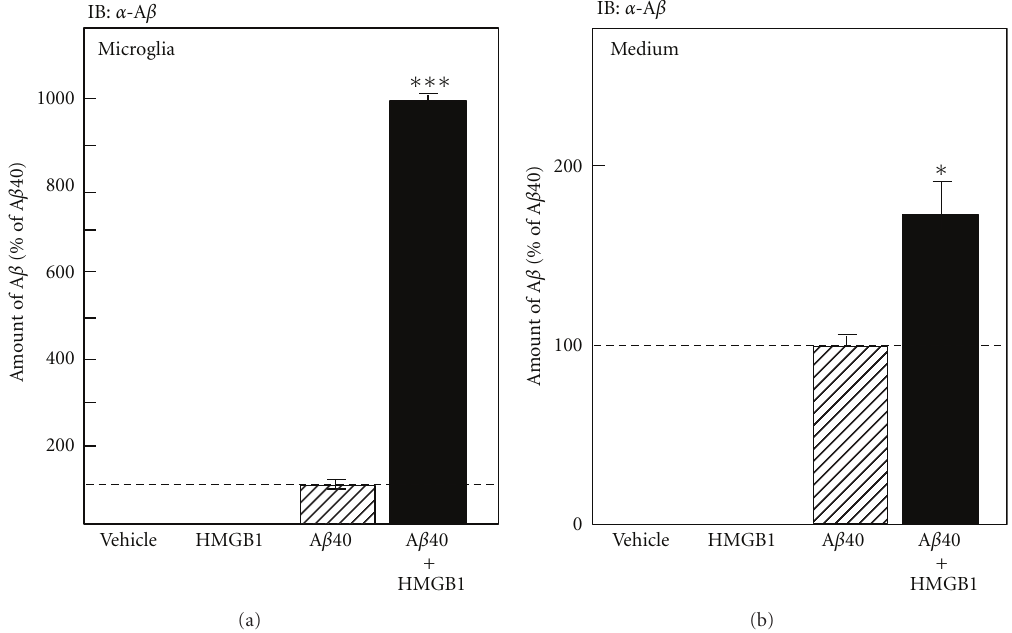
Figure 3: E ff ect of exogenous HMGB1 on microglial A β phagocytosis analyzed by Western blot. Rat microglia were incubated with the vehicle, HMGB1, A β 40, or A β 40 and HMGB1 for 12 h. Microglial cell lysate (a) and conditioned medium (b) were then subjected to Western blot analysis using the anti-A β antibody, and then the amounts of A β 40 inside (a) and outside microglia (b) were semiquantitatively measured. ∗ P < 0 . 05, ∗∗∗ P < 0 . 001 versus treatment with A β 40